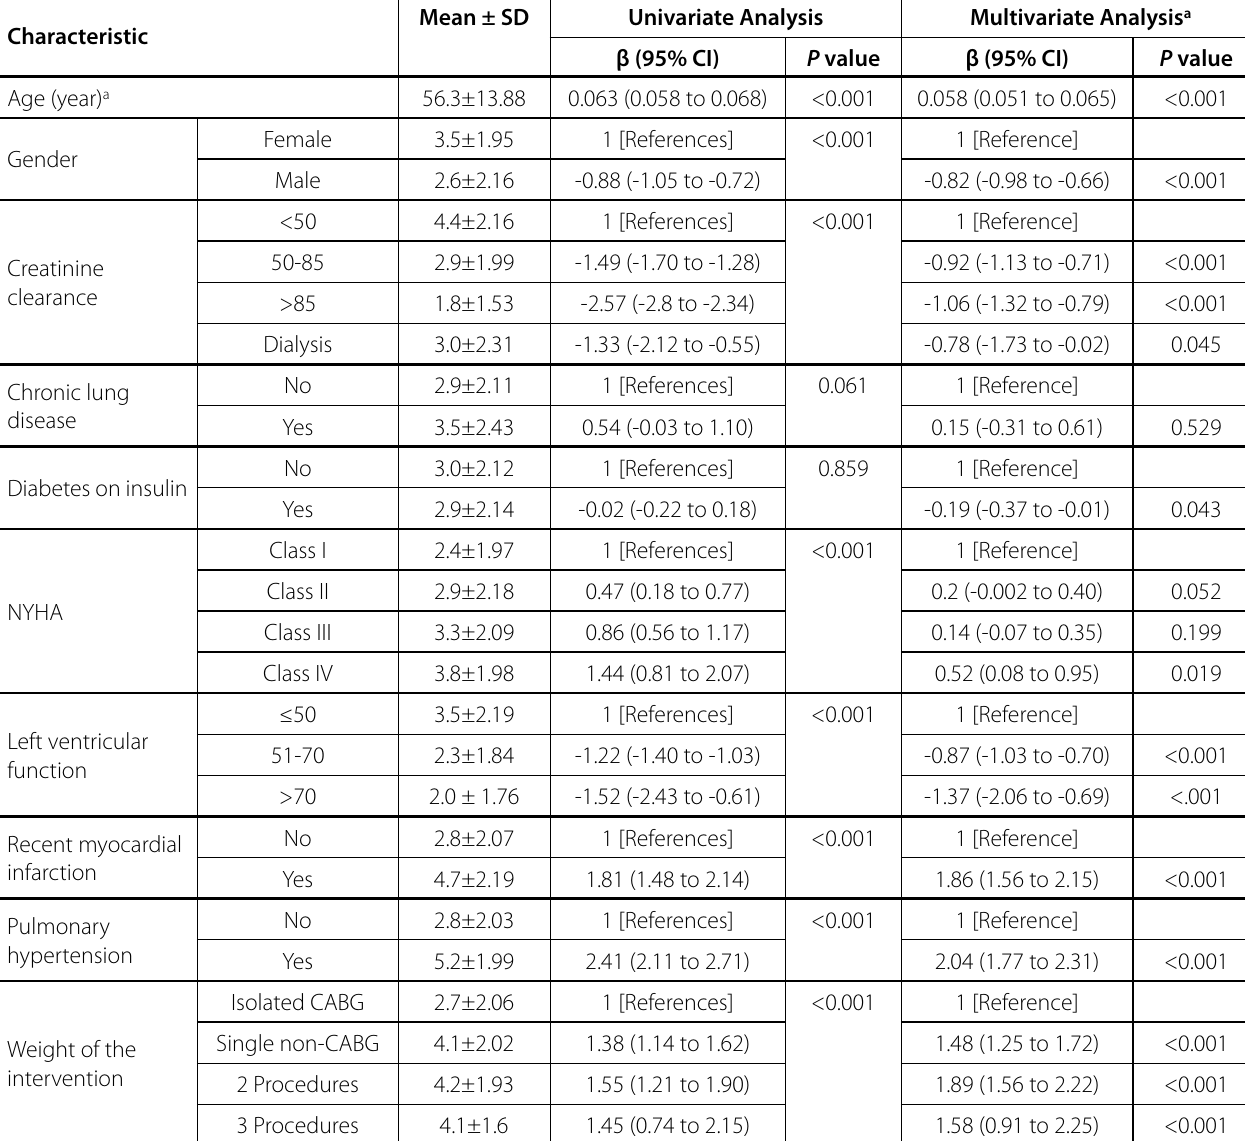
Table 3. Univariate and multivariate analysis of EuroSCORE II prognostic factors [2] .